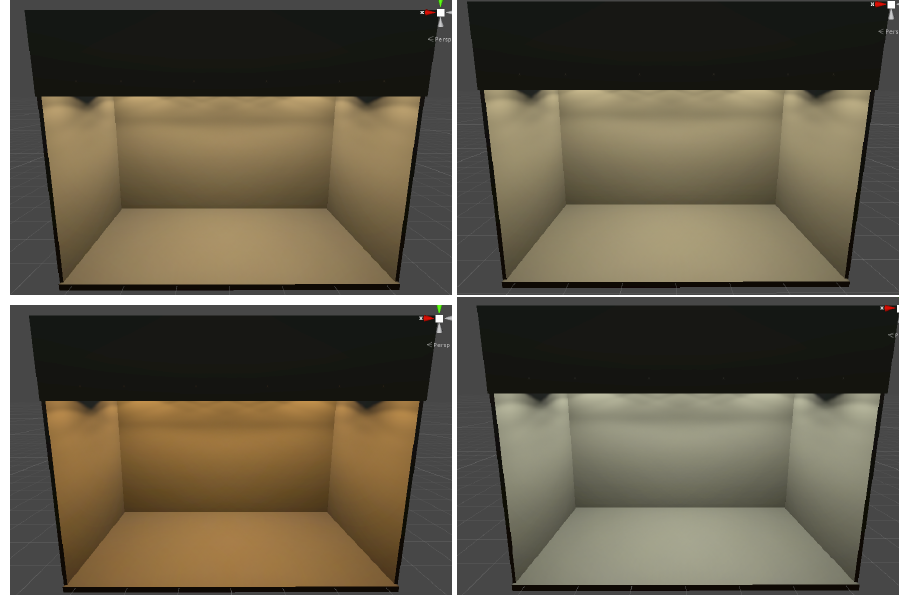
Figure 6. Different light sources represented in our virtual reality scene. TL84 ( top left ), D50 ( top right ), A ( bottom left ) and D65 ( bottom right